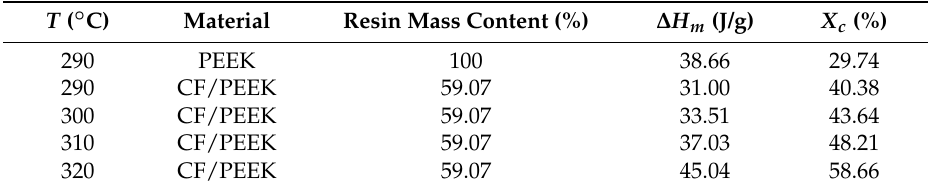
Table 2. DSC results for different samples. ( T is the tested crystallization temperature; ∆ H m is the enthalpy; X c is the crystallinity).